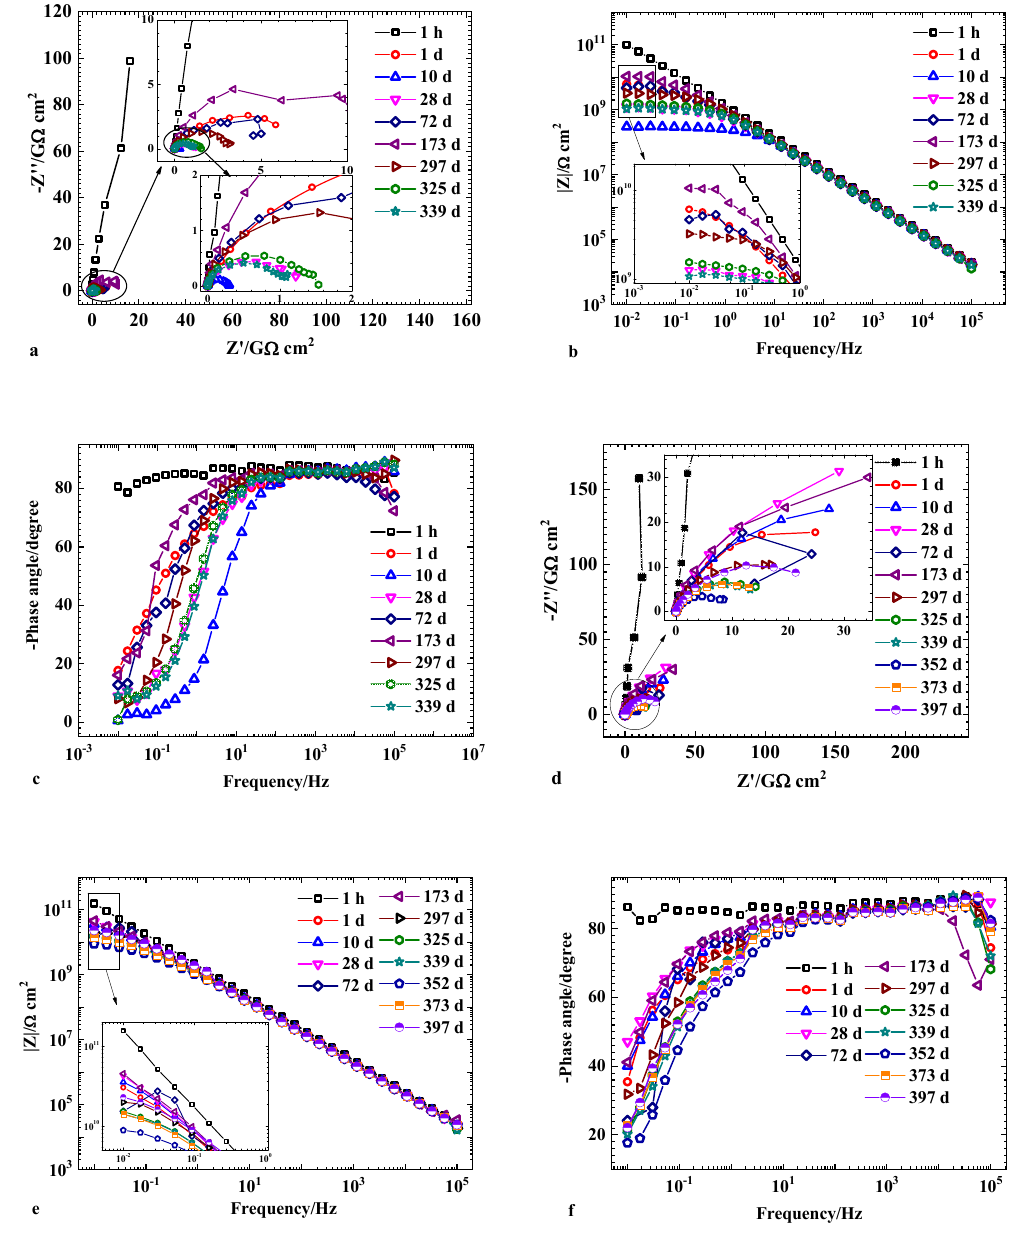
Figure 3. Electrochemical impedance spectroscopy (EIS) spectra of MRP and SAP-MRP samples after immersion in the simulated acid rain solution for different days: ( a ) Nyquist plots of MRP; ( b , c ) Bode plots of MRP; ( d ) Nyquist plots of SAP-MRP; ( e , f ) Bode plots of SAP-MRP.